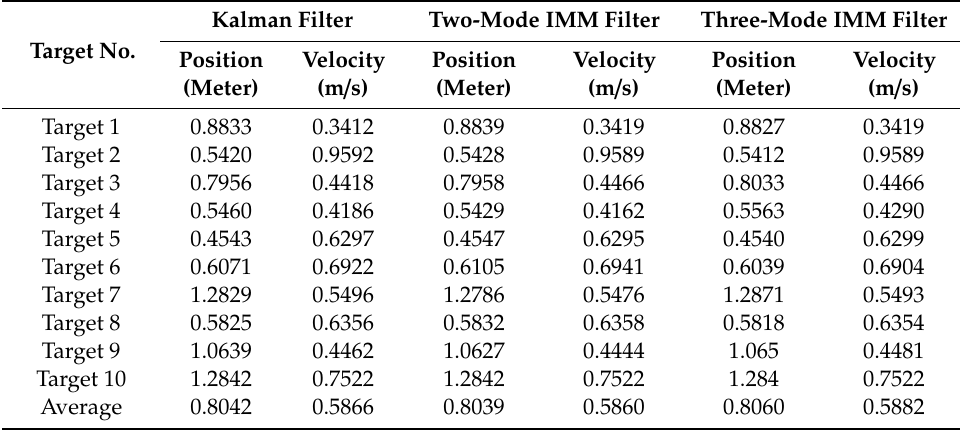
Table 3. Root-mean squared errors (RMSE) of position and